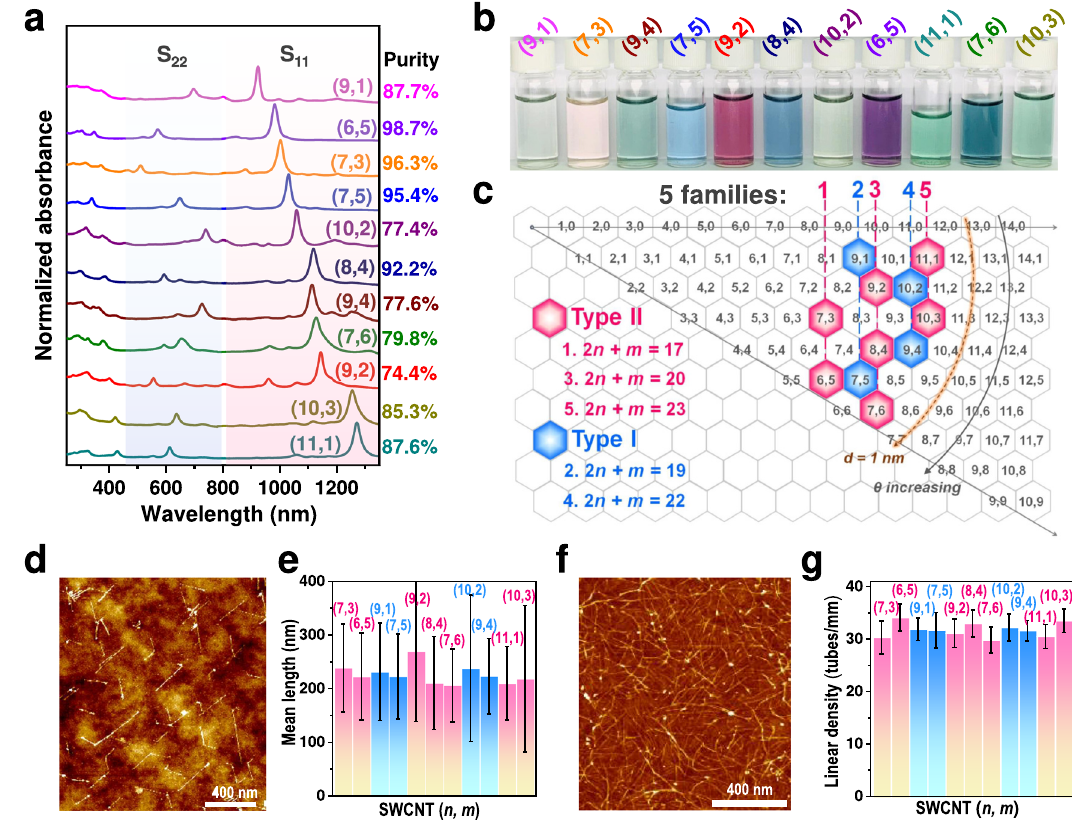
Fig. 1 | Characterization of the single-chirality SWCNTs used in the present study. a Optical absorption spectra of the ( n, m ) single-chirality SWCNTs. Their chiral purities are evaluated by peak fi tting and indicated on the right